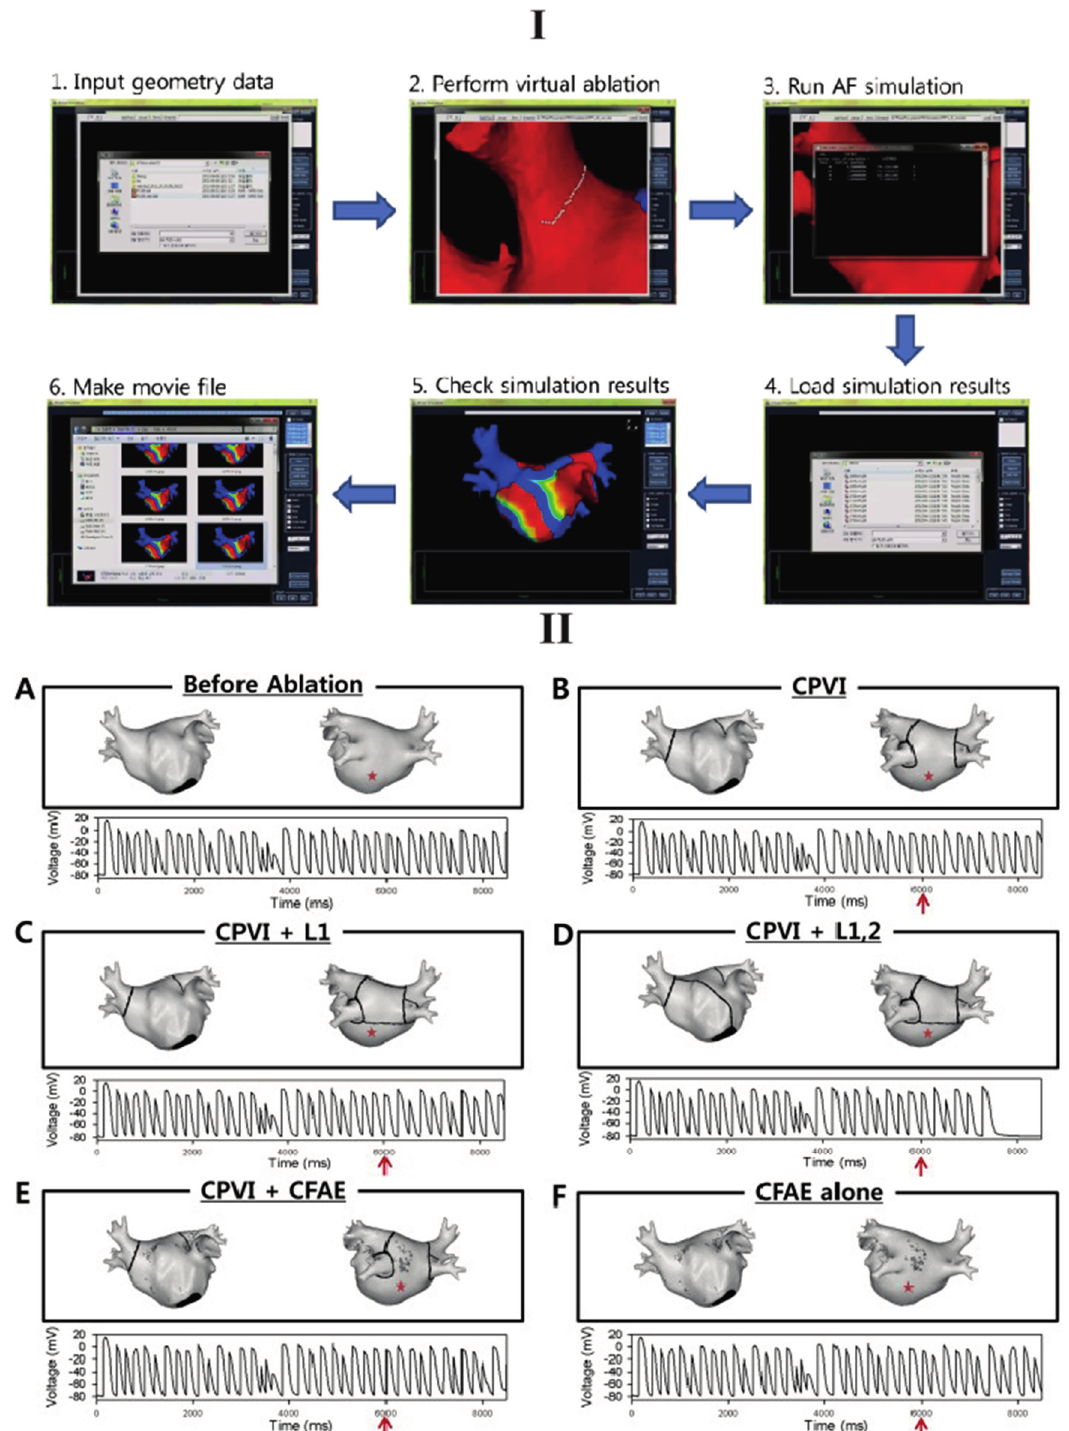
Figure 3. The clinical usage of a computer model for planning personalized ablation strategies was demonstrated [43]. ( I ) A GUI was displayed for performing virtual ablation; ( II ) Top : ( A ) pre-ablation and five ablation patterns were employed in this study: ( B ) PVI; ( C ) PVI + posterior linear ablation (L1); ( D ) PVI + both posterior and anterior linear ablation (L1,2); ( E ) PVI + CFAE; and ( F ) CFAE alone; Bottom : Atrial electrograms were displayed at a specified location (red asterisk) before and after (red arrow) RFCA. Reprinted from [43] with permission from